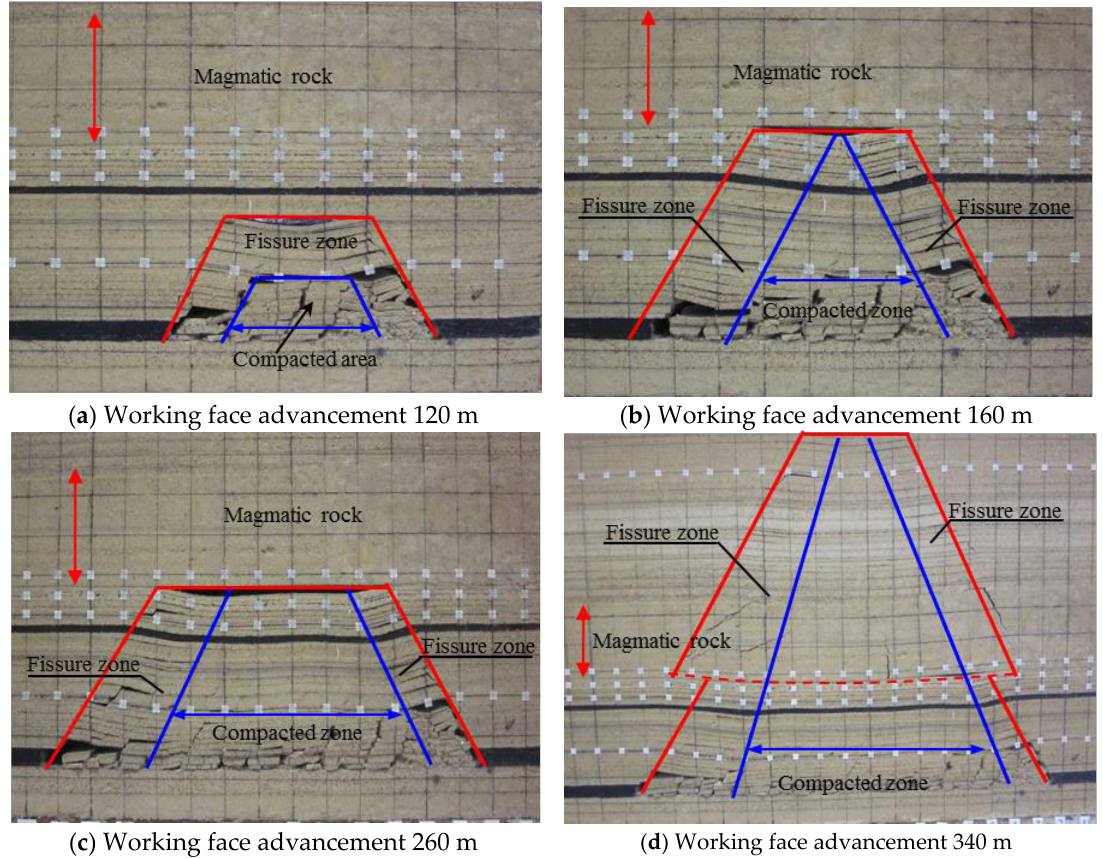
Figure 8. The distribution characteristics of fractures in overburden.